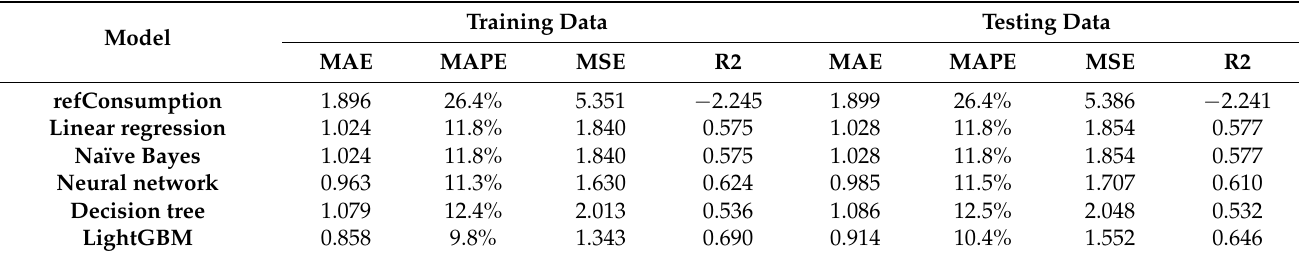
Table 6. Results of regression model training and testing.